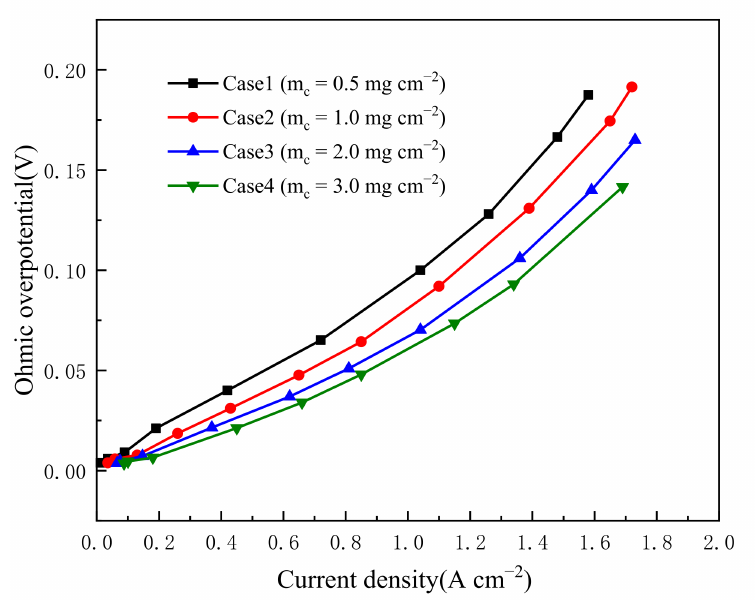
Figure 7. Effect of carbon loading on Ohmic overpotential.